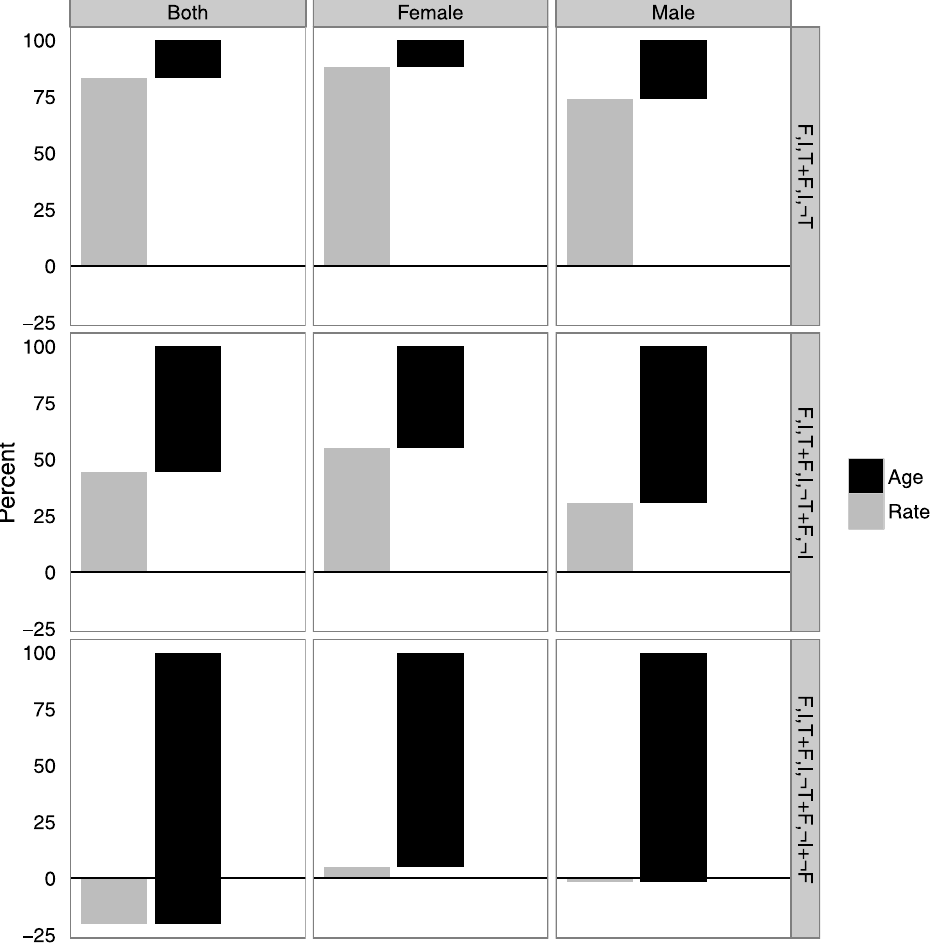
Figure 3. Decomposition of sub-group crude rates into rate and age composition differences using the multi-stage approach, Agincourt HDSS 2010 – 2011. Rate and age differences sum to 100% for each sex subgroup. For those who were found F , for those who were found and interviewed F , I , and for those who were found, interviewed, and tested F , I , T . We use the negation operator : to indicate ‘the opposite of’ – i.e. : F means ‘not found’.